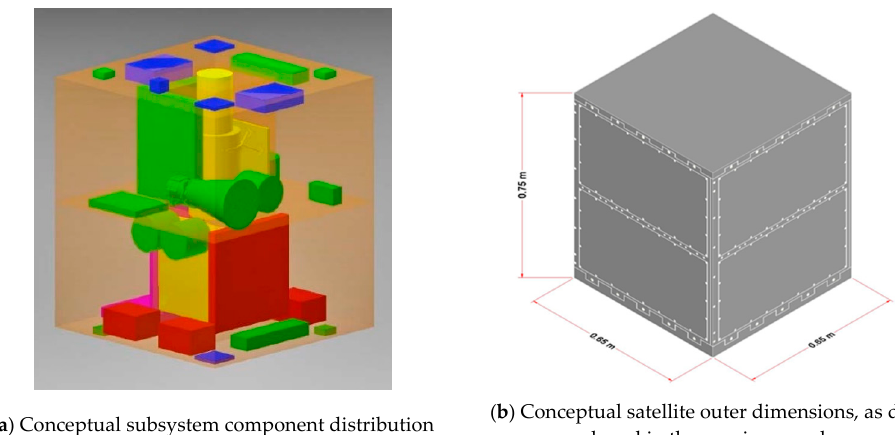
Figure 1. Conceptual satellite designs, as developed in the previous work.